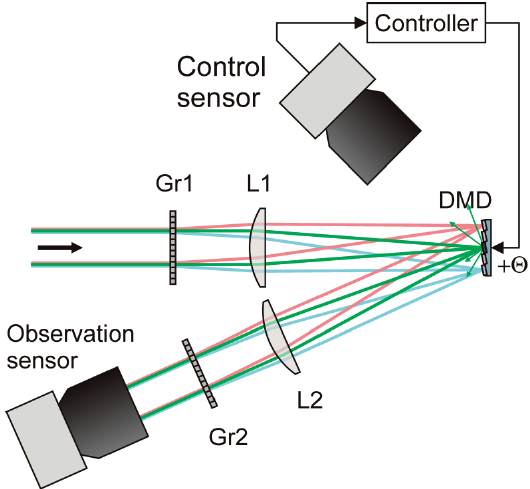
Figure 3. Scheme of the optical setup for an improved implementation of the control loop.